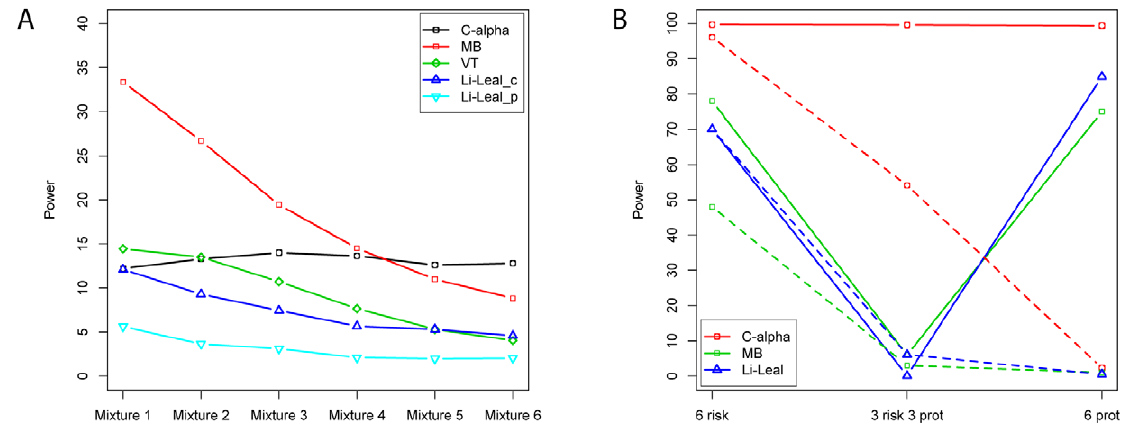
Figure 3. Power comparisons and variants. (A) shows power comparisons for the population genetics model simulations. Power comparisons are for C-alpha, Madsen-Browning (MB), Variable threshold (VT), and Li-Leal’s approach (presence/absence Li-Leal_p and count of rare variants Li- Leal_c). These simulations reflect the presence of selection on the variation which predisposes to phenotype. As we increase the mixing proportions between risk and protective variants (moving from mixtures 1 to 6, which reflects 0, 10, 20, 30, 40 and 50% chance of any of the phenotypically relevant variants are protective, rather than risk), C-alpha maintains power, while other tests lose power. In (B), the each of 6 variants explains 0.1% of the variance of the phenotype. All three approaches have high power when all the effects are detrimental. For burden tests, the power drops markedly when 3 variants are protective and 3 are detrimental. ‘‘Selected’’ controls are chosen from the lower 1% of the liability distribution. The solid (dashed) lines represent power for selected (unselected)